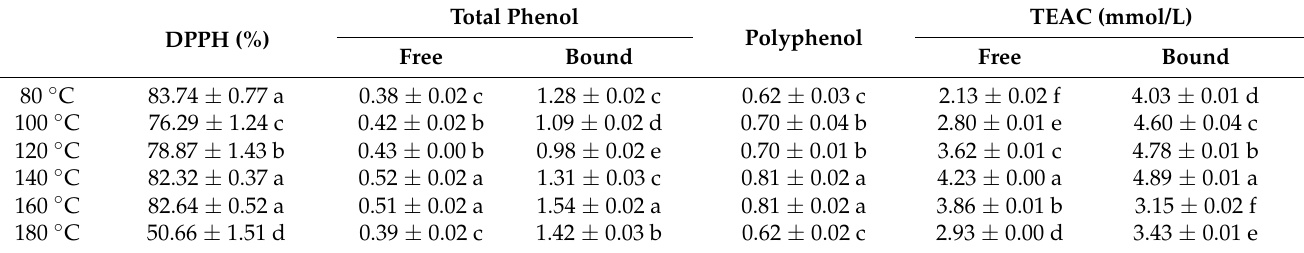
Table 2. Antioxidant properties of Shiitake mushroom roasted in different